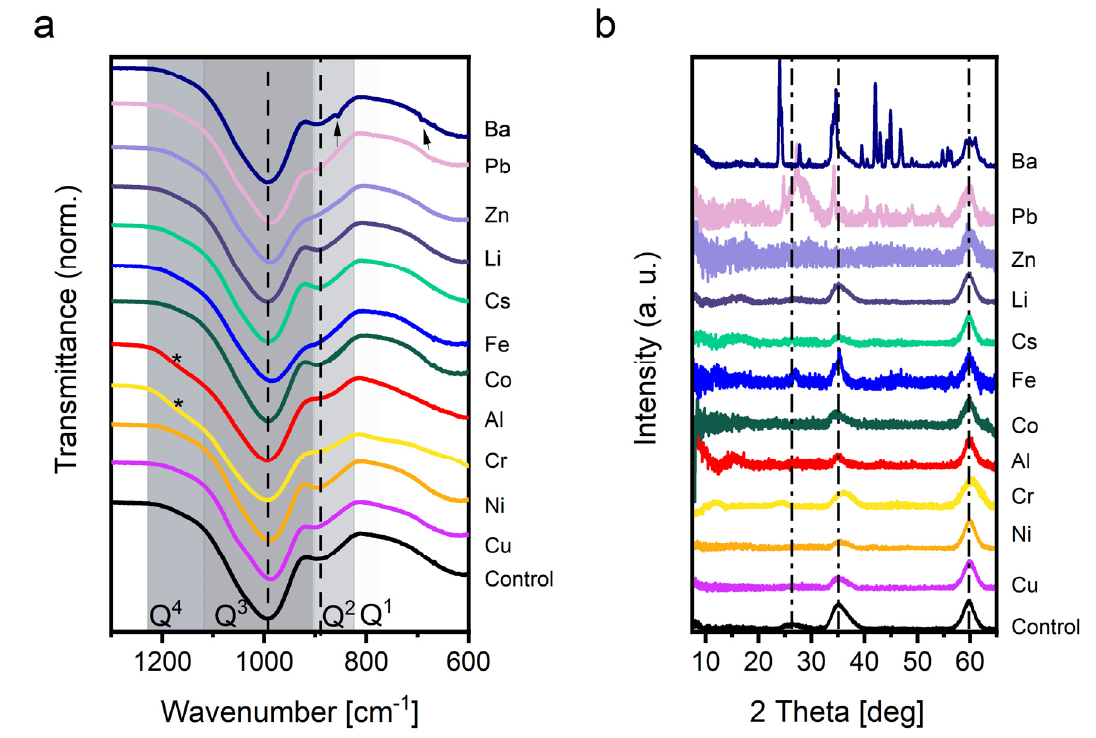
Figure 2. ( a ) Fourier transformed infrared spectroscopy (FTIR) spectra of M-S-H with additive ions. * mark shoulders belonging to Q 4 silica networks and arrows bands at 960 and 690 cm − 1 from carbonate groups in the Ba sample; ( b ) X-ray diffraction (XRD) diffraction pattern for M-X-S-H normalized to the reflex at 59.9° 2 theta.